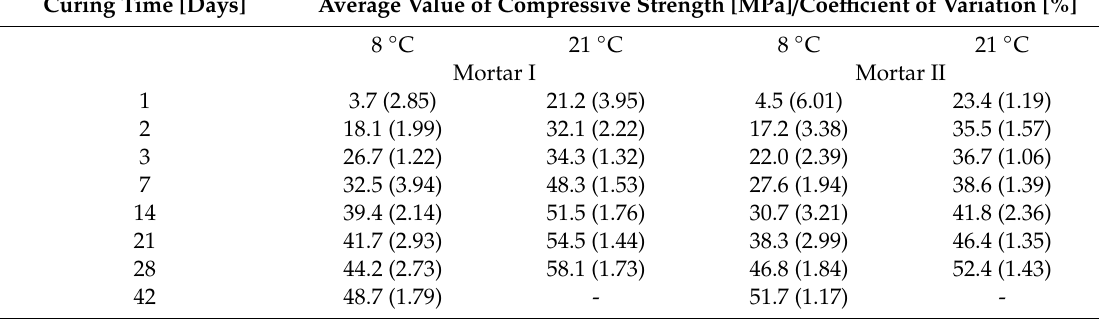
Table 5. Average value of compressive strength and coefficient of variation of mortars cured at 8 °C and 21 °C, following subsequent curing periods.